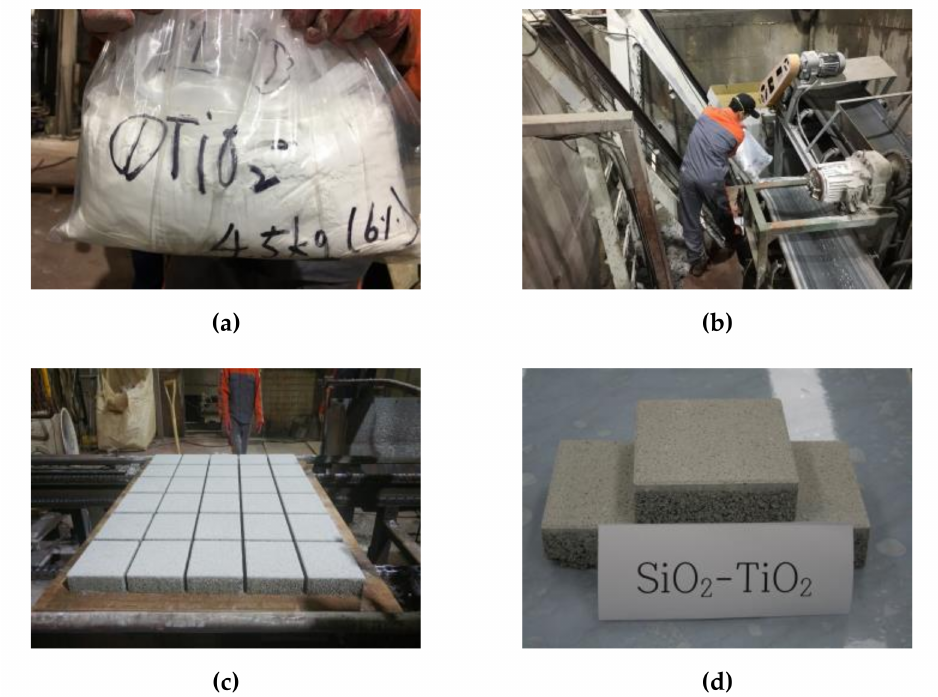
Figure 5. Manufacture of the concrete blocks: ( a ) material preparation; ( b ) manufacture; ( c ) block production; and ( d ) concrete